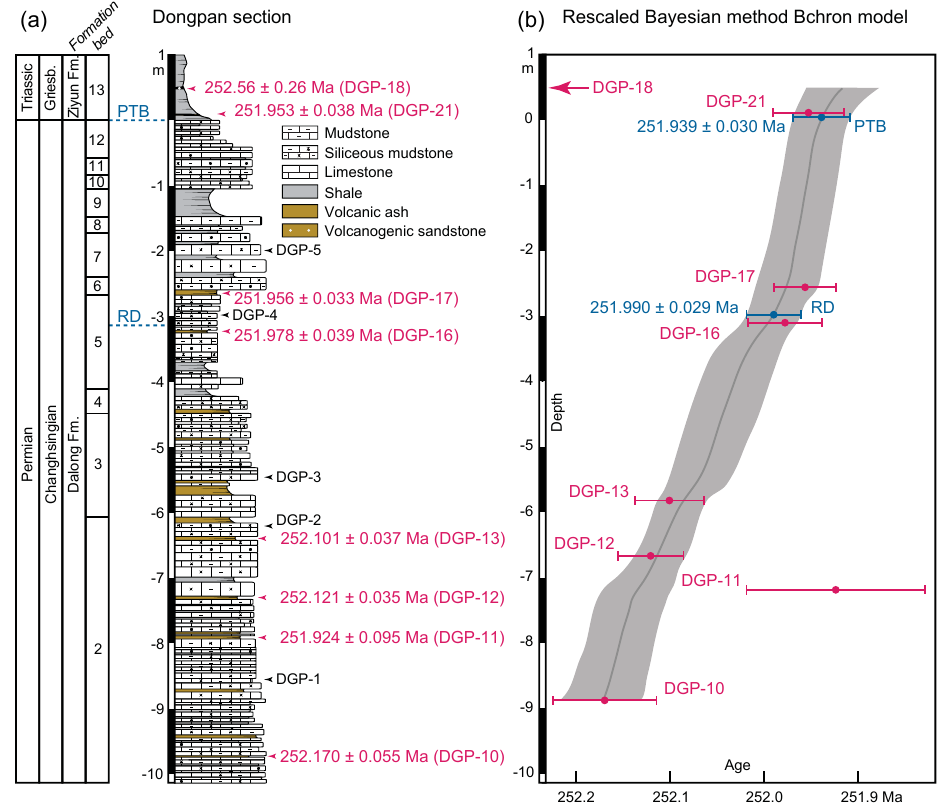
Figure 2. Stratigraphy, geochronology and Bayesian age–depth modeling for the Dongpan section from late Changhsingian to Griesbachian. (a) Weighted mean 206 Pb / 238 U dates of the volcanic ash beds and volcanogenic sandstones are given inMa. U-Pb data of DGP-21 are taken from Baresel et al. (2016). Investigated radiolarian samples (DGP-1 to DGP-5) are shown in their stratigraphic positions. (b) The rescaled Bayesian Bchron age–depth model is presented with its median (middle grey line) and its 95% confidence interval (grey area). Radioisotopic dates together with their uncertainty (red horizontal bars) are presented as 206 Pb / 238 U weighted mean dates of the dated volcanic ash beds in their stratigraphic positions. Predicted dates for the onset of the radiolarian decline (RD) and the Permian–Triassic boundary (PTB) are calculated with their associated uncertainty using the rescaled Bayesian Bchron age–depth model assuming stratigraphic